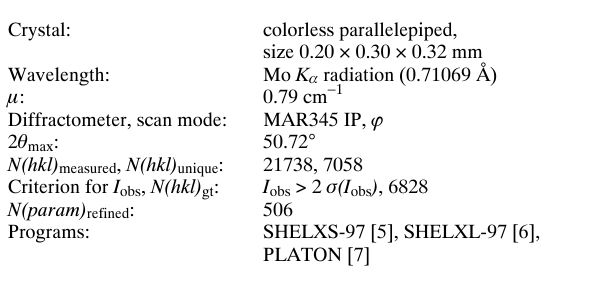
Table 1. D a t a collection a nd h a